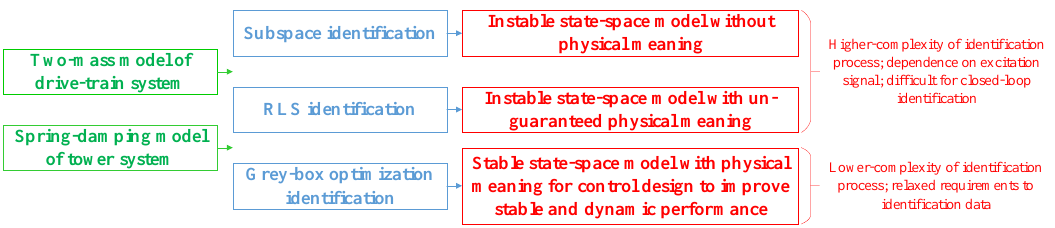
Figure 16. Application potential and features of different identification methods.